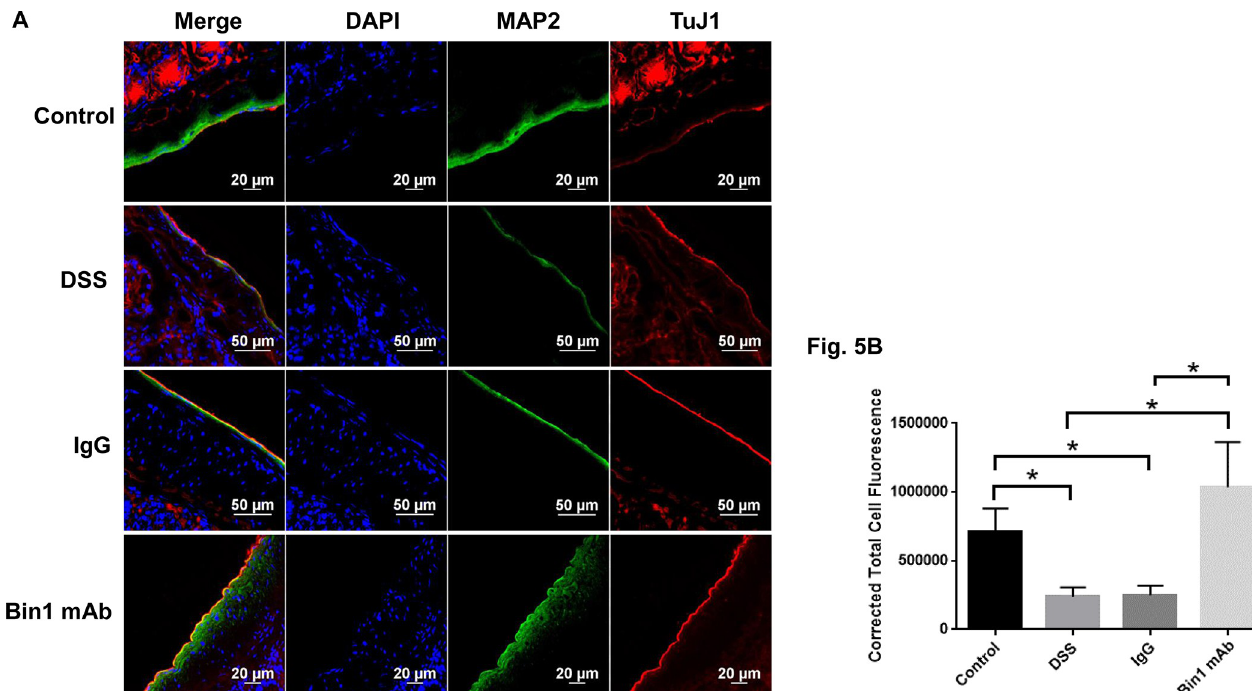
Fig 5. Bin1 mAb treatment improved MAP2 expressing enteric neurons after DSS-induced colitis. Fig 5A . Effect of Bin1 mAb treatment on the expression of MAP2 and TuJ1 neuronal cells in the colon of DSS-induced colitis mice as determined by confocal microscopy. Representative image from two independent experiments shown. Fig 5B . Bin1 mAb treated mice had high levels of MAP2 expressing neuronal cells in the muscularis of the colon as quantitated by CTCF analysis (CTCF analysis, n = 3 mice tissues per treatment) ( � P < 0.05 as determined by t test). Control and DSS � p < 0.0112, Control and IgG � p < 0.0124, DSS and Bin1 mAb � p < 0.0144, IgG and Bin1 mAb � p <